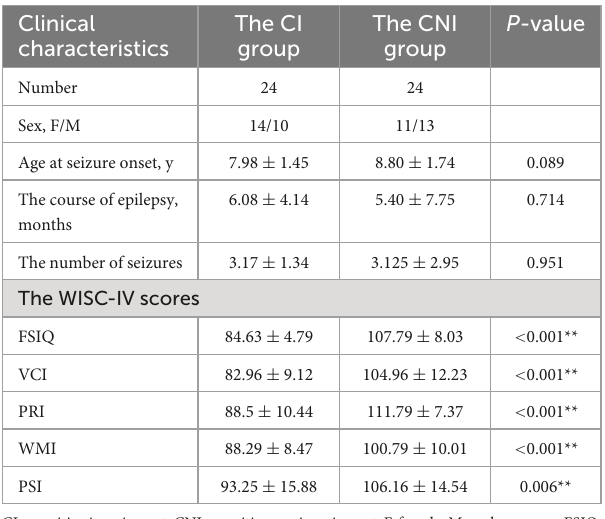
TABLE 1 Clinical information of patients. Clinical